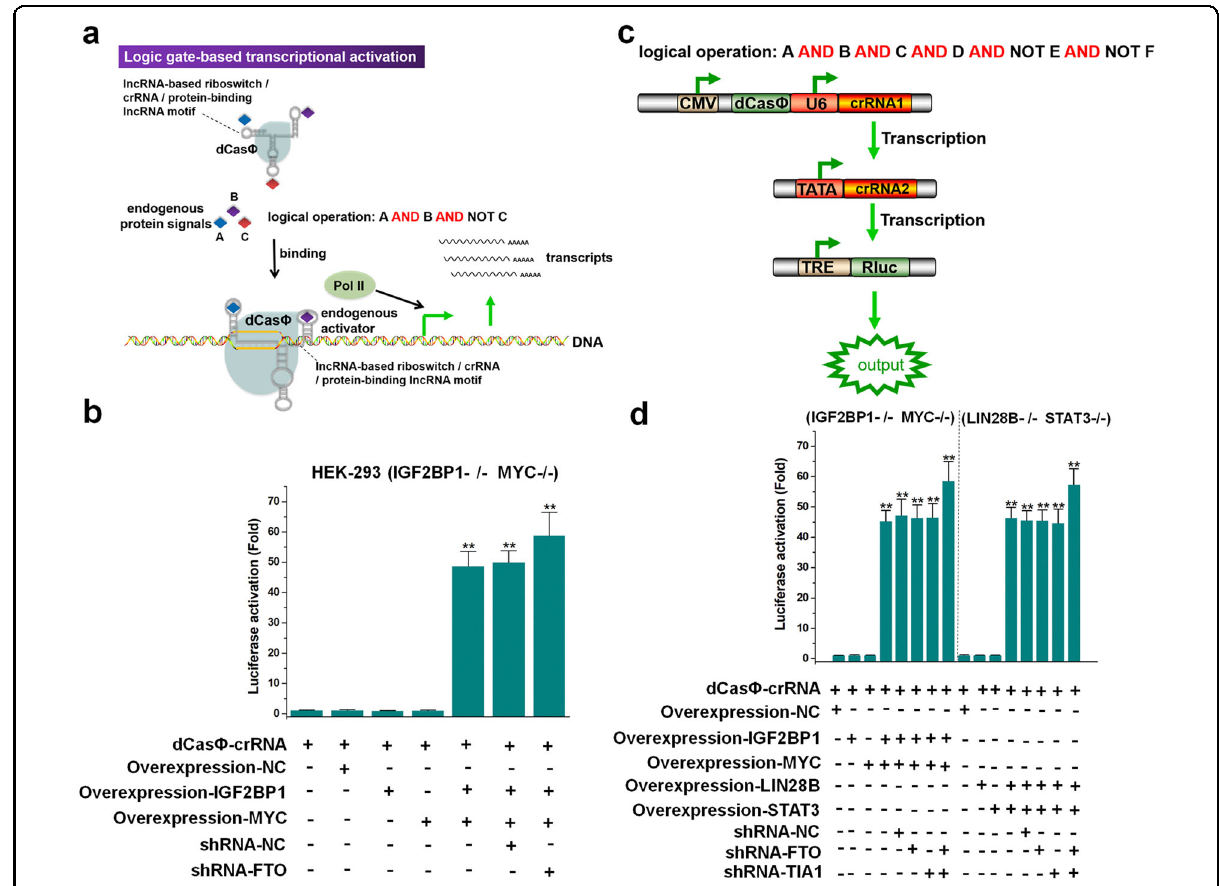
Fig. 6 Design and construction of multi-input logic gates using signal conductor 2.0. a Schematic diagram showing the logic gate-based transcriptional activation. The CRISPR-dCas Φ system activated the expression of target gene only when the logical condition “ A AND B AND NOT C ” was established. b The expression level of Rluc was regulated by the logic gate, which performed the “ LIN28B AND STAT3 AND NOT TIA1 ” operation. c Schematic diagram showing the logic gate performing the logical operation “ A AND B AND C AND D AND NOT E AND NOT F. ” d The expression level of Rluc was regulated by the logic gate, which performed the “ IGF2BP1 AND MYC AND LIN28B AND STAT3 AND NOT FTO AND NOT TIA1 ” operation. Relative luciferase activities were determined as the ratios of Rluc to Fluc values. The fold change in each group was determined by comparison with the crRNA negative control. Error bars represent the SD from fi ve independent experiments. * P <0.05; ** P <0.01, relative to the control, two-tailed t